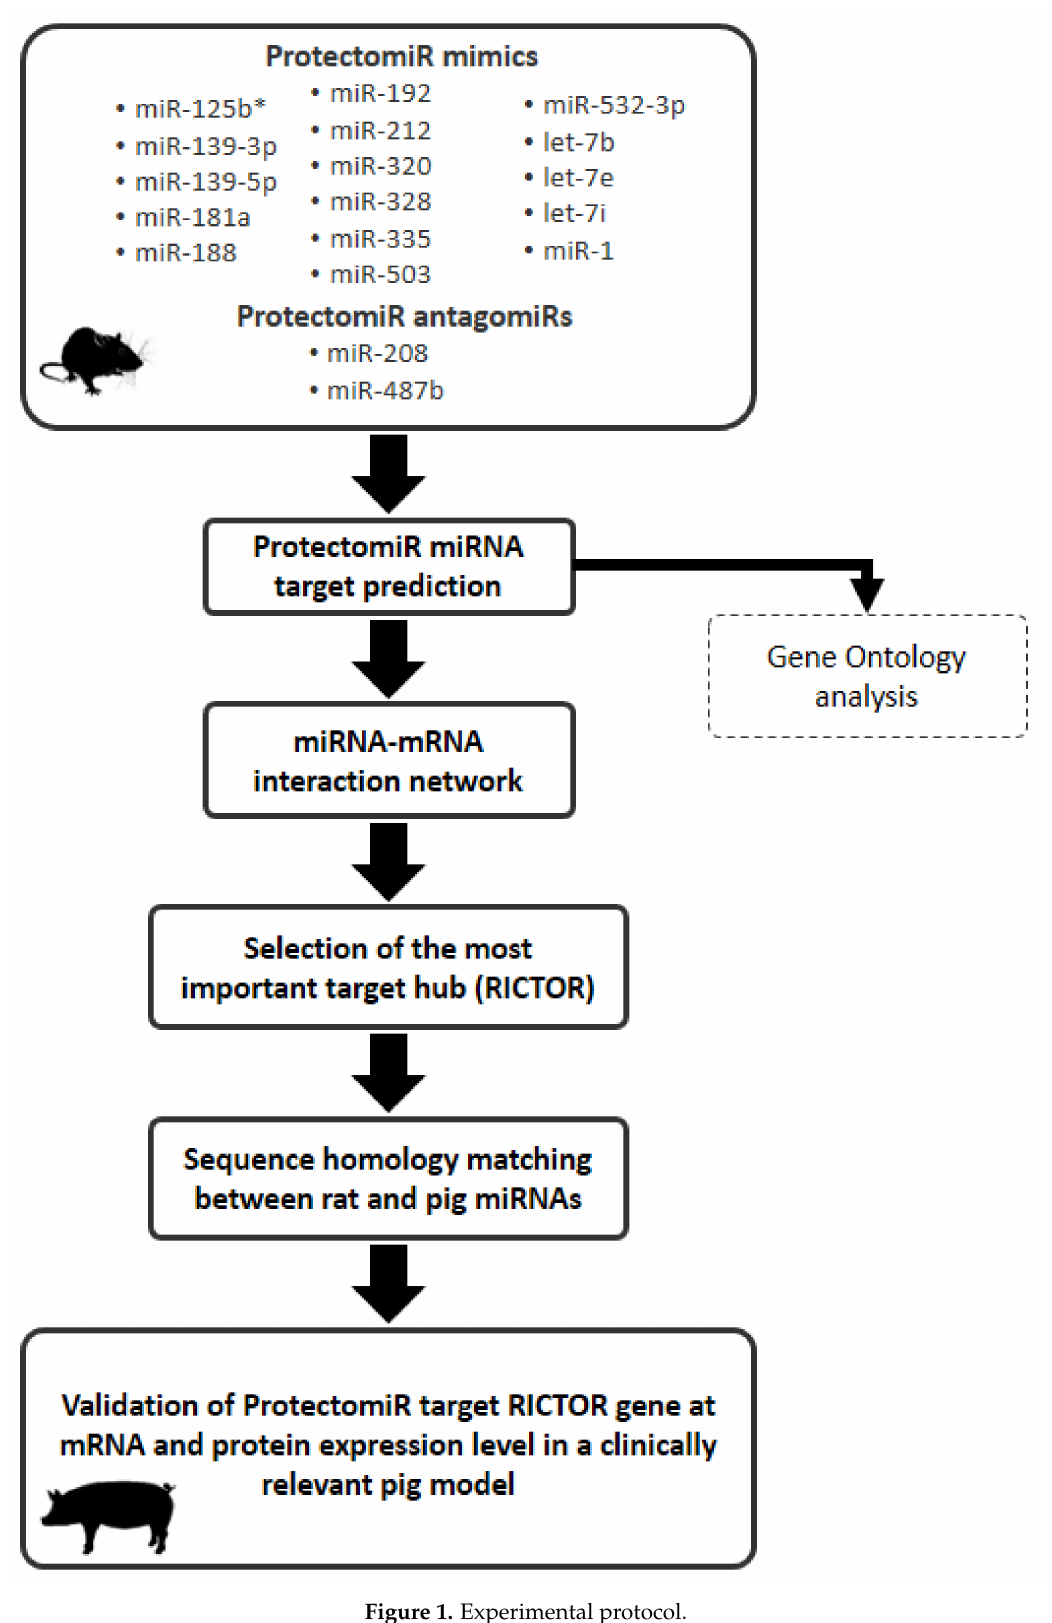
Figure 1. Experimental